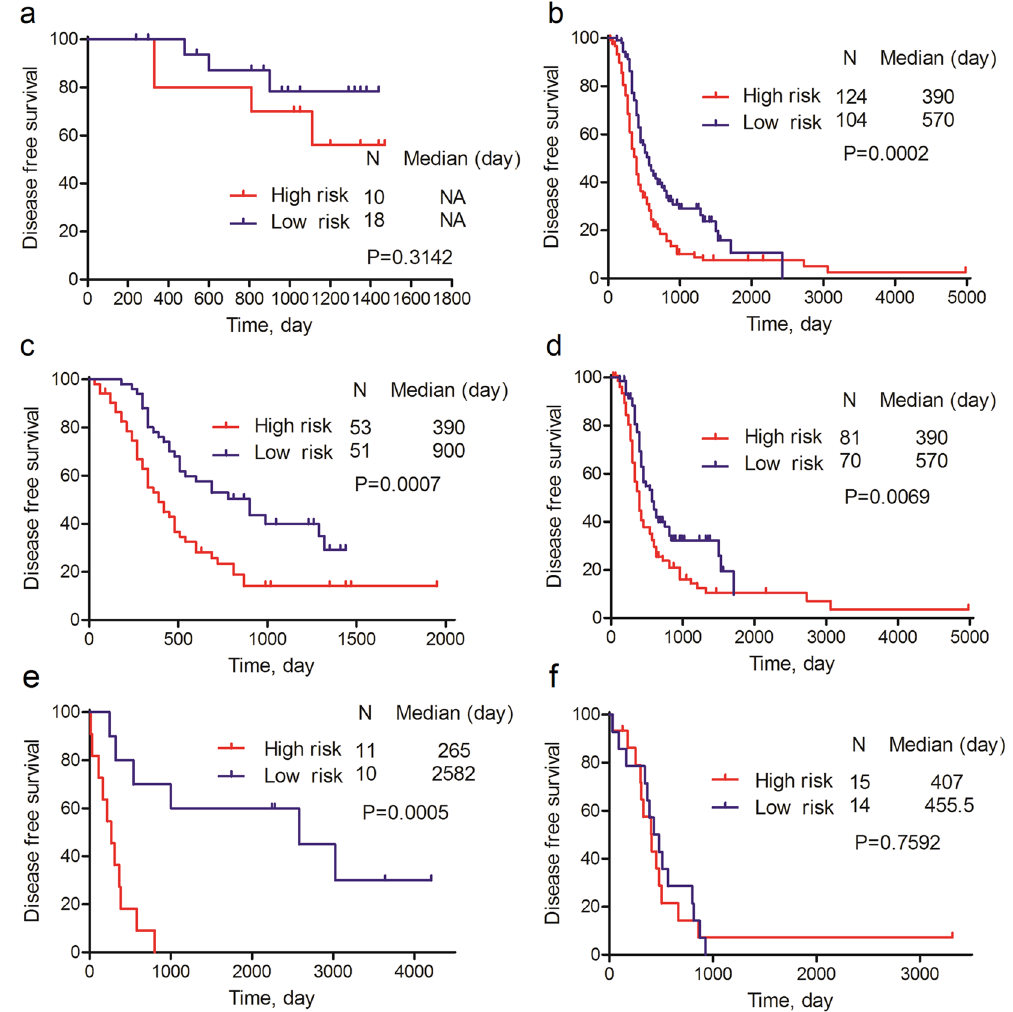
Figure 4. Sub-group analysis of association between six-lncRNA signature and DFS of OvCa patients. ( a ) K-M curve of early-stage OvCa patients in GSE9891. ( b ) K-M curve of late-stage OvCa patients in GSE9891. ( c ) K-M curve of low-grade OvCa patients in GSE9891. ( d ) K-M curve of high-grade OvCa patients in GSE9891. ( e ) K-M curve of low-grade OvCa patients in GSE30161. ( f ) K-M curve of high-grade OvCa patients in